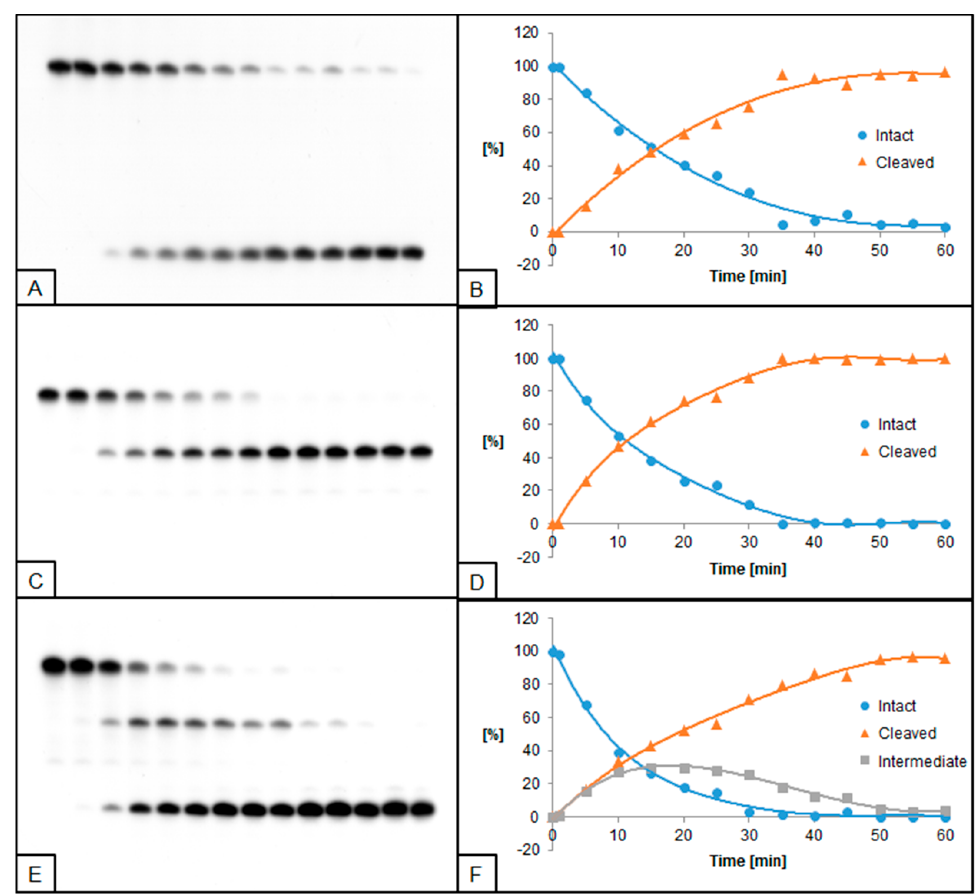
Figure 5. Cleavage of dsDNA containing dU and (5 ′ S ) − 5 ′ ,8-cyclo-2 ′ -deoxyguanosine (ScdG) by 0.02 U UDG and 0.5 U hAPE1. ( A , B ) dU( − 5)ScdG; ( C , D ) dU(+5)ScdG; ( E , F ) dU( − 5)(+5)ScdG. ( A , C , E ) show 14 lanes each, which correspond to reaction times 0, 1, 5, 10, 15, 20, 25, 30, 35, 40, 45, 50, 55, and 60 min starting from the left. ( B , D , F ) show the quantity loss of intact ssDNA (blue), the quantity increases of SSB-DNA (orange), and an intermediate oligo fragment (grey).